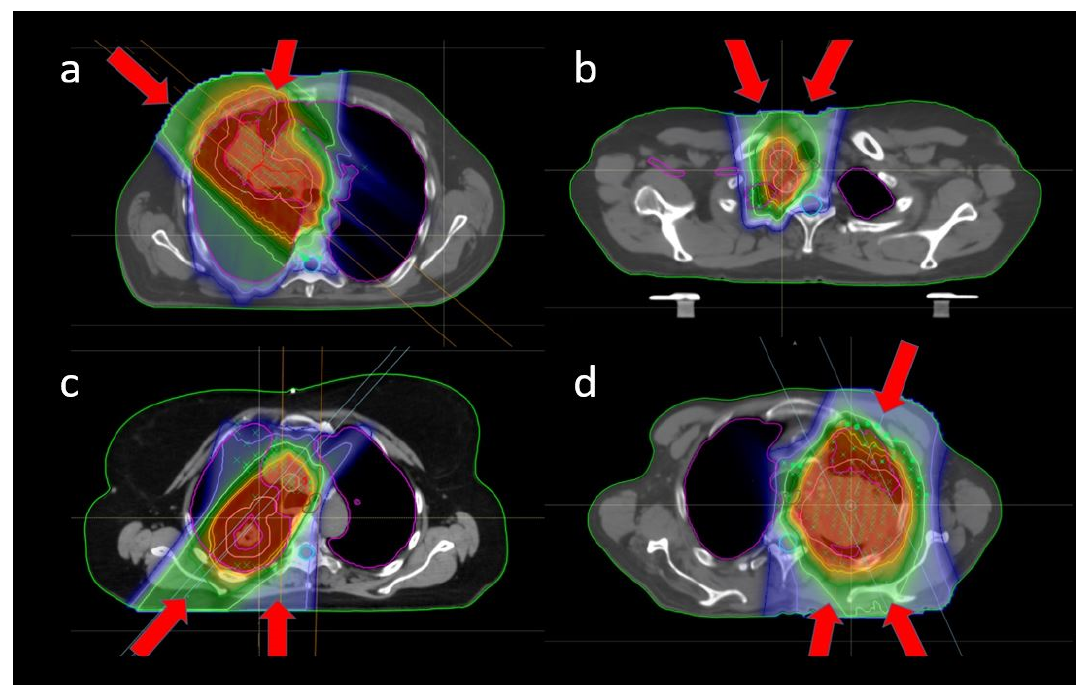
Figure A1. Common beam configurations for different tumor locations: ( a ) frontal oblique tumor with oblique and frontal fields, ( b ) nodes in the frontal part of the mediastinum with two slightly frontal oblique fields, ( c ) dorsal tumor with dorsal oblique and dorsal fields, and ( d ) large tumor near the brachial plexus, with slightly frontal oblique, dorsal and dorsal oblique fields.